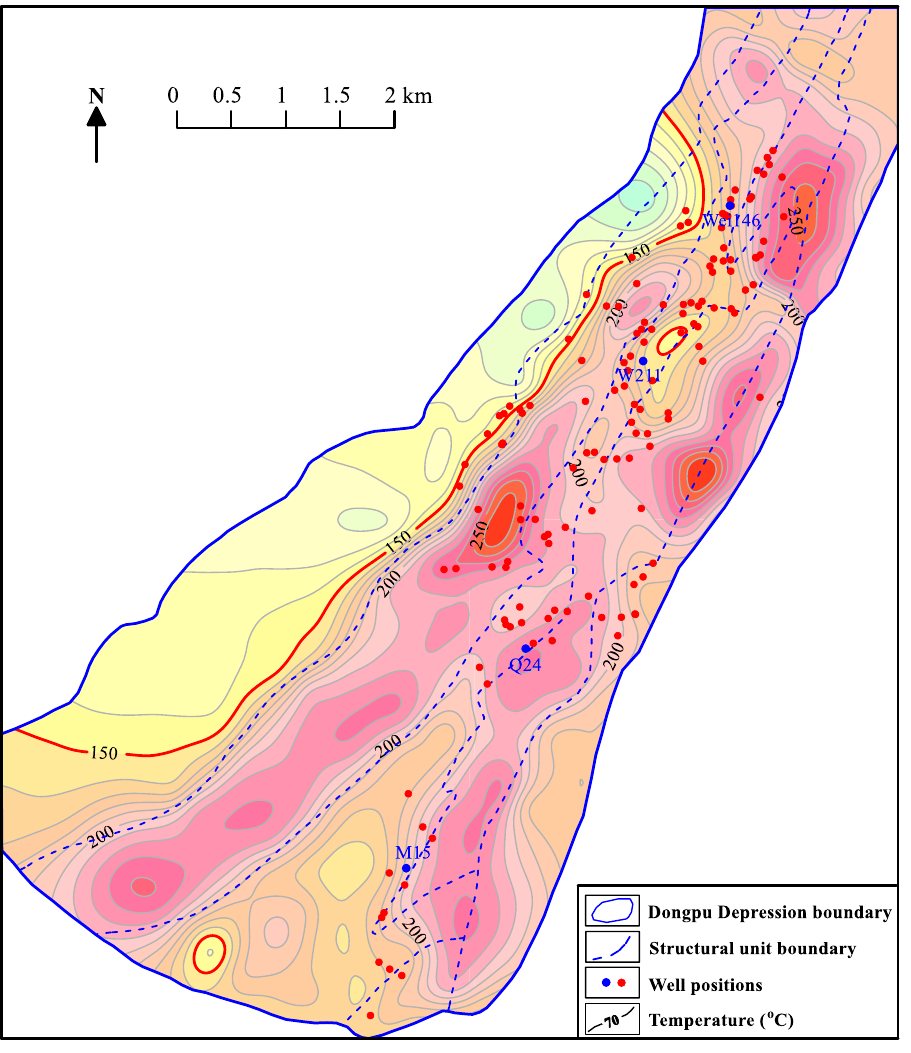
Figure 8. Cenozoic bottom temperature in the Dongpu Depression. Figure was produced by Surfer 15 (https:// www. golde nsoft ware. com/ produ cts/ surfer/) and BasinView 2012 (https:// www. platte. com/ softw are/ basin view/).